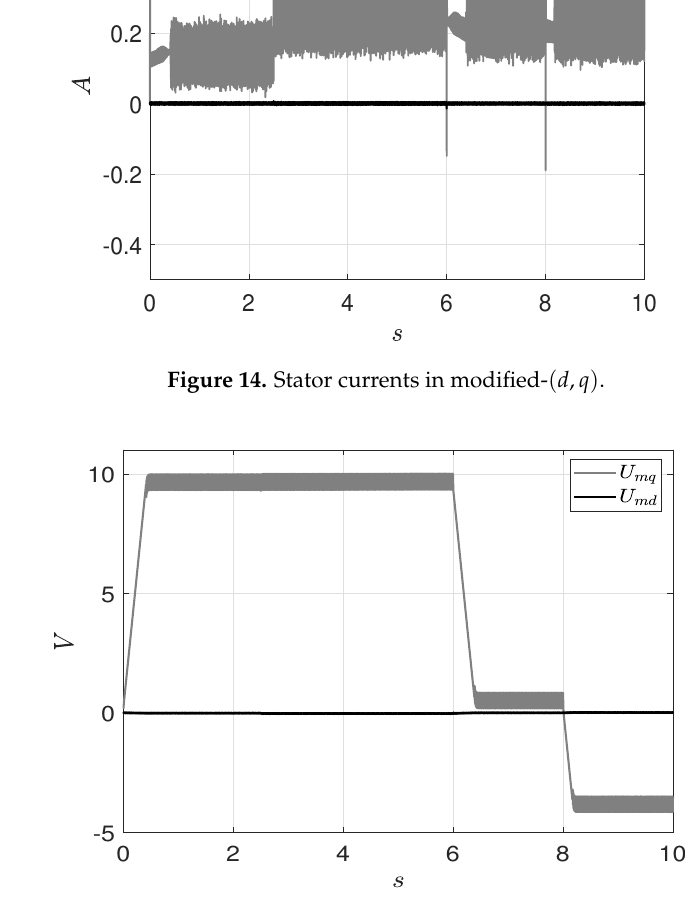
Figure 15. Control voltage in modified- ( d , q )